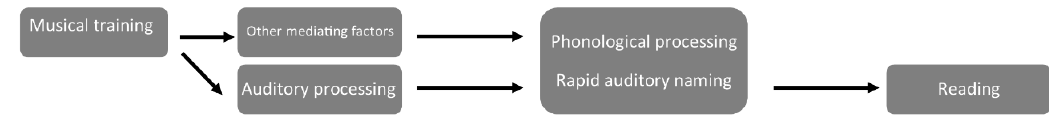
Figure 4. One Putative Pathway by which Musical Training May Strengthen Reading-Related Skills. We propose that musical training bolsters reading subskills through sensorineural auditory processing [4,18]. However, there are other likely pathways through which a music advantage may occur (e.g., auditory working memory, attention) [4].